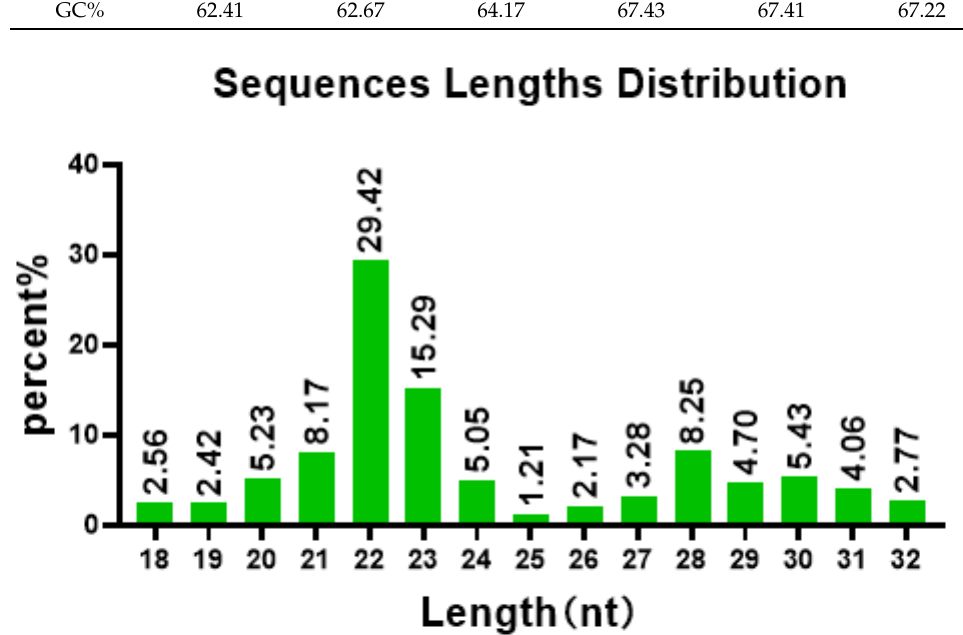
Figure 3. sRNA length distribution. The abscissa represents the miRNA length, and the ordinate represents proportion of miRNA at this length.